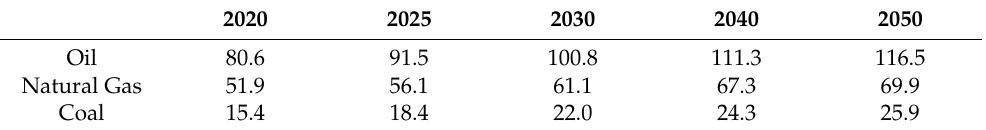
Table 3. Evolution of international fossil fuel prices, € per barrels of oil equivalent, EUR 2016/boe.